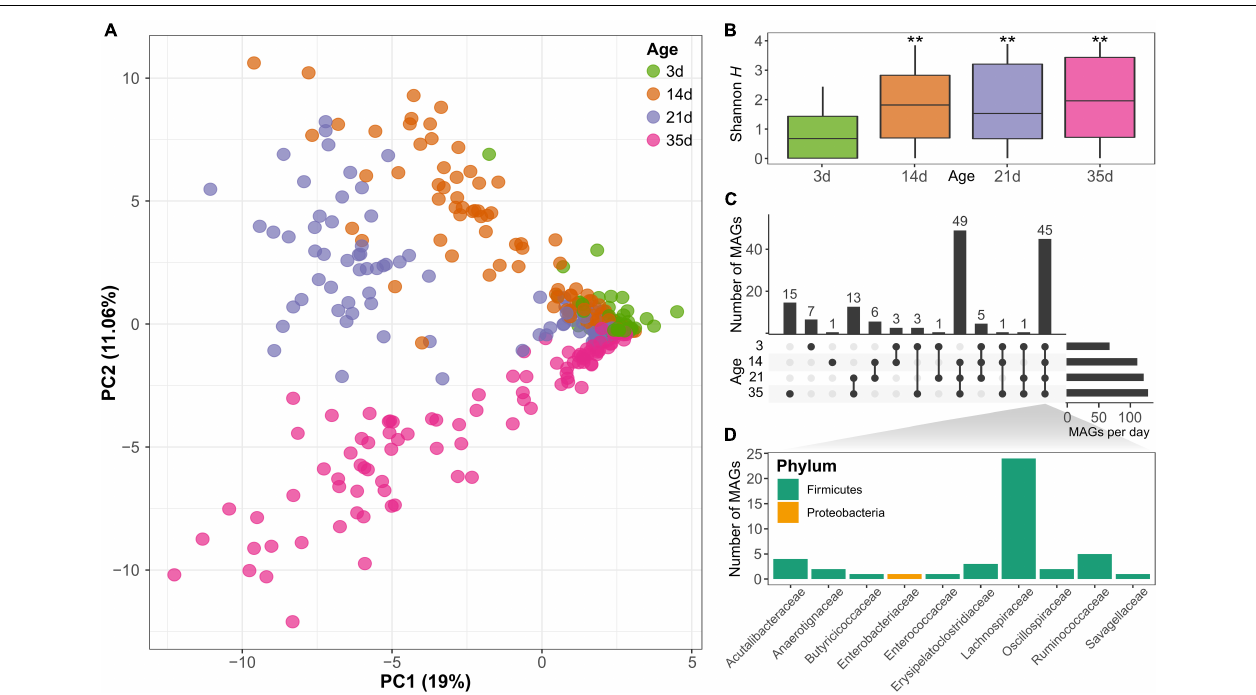
FIGURE 2 | (A) Principal component analysis based on the metagenomic assembled genomes (MAGs) content clearly differentiates between samples at different ages (PERMANOVA; p < 0.001). (B) Shannon diversity increased significantly with the age of the chicken (**Kruskal-Wallis rank-sum test; p < 0.001). (C) Number of MAGs shared at different time points reveals there is a core group of 45 bacterial genomes that can be identified at all time points. (D) The core genomes present at all time points belong to several families mainly of the phylum Firmicutes, especially